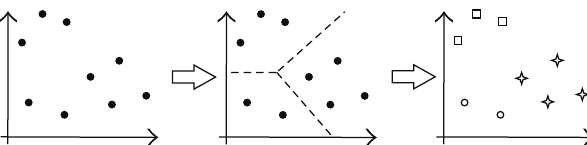
Figure 11: Visualization of how points in the target density distribution feature space are convexly partitioned. In this example three partitions are classified. The resulting three partitions are represented by circles, stars, and